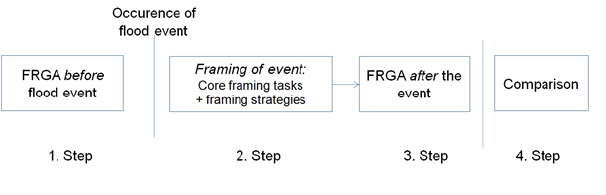
Fig. 1 . Research steps per event and per country. FRGA = flood risk governance arrangement.